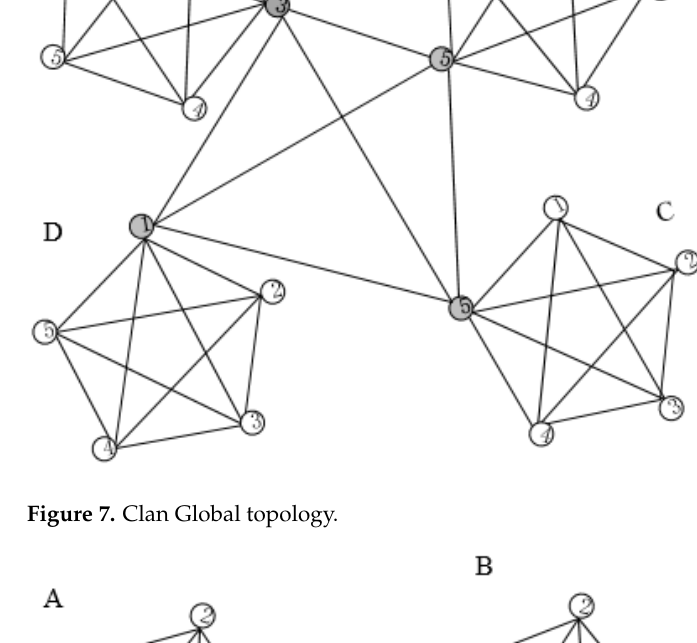
Figure 7. Clan Global topology.